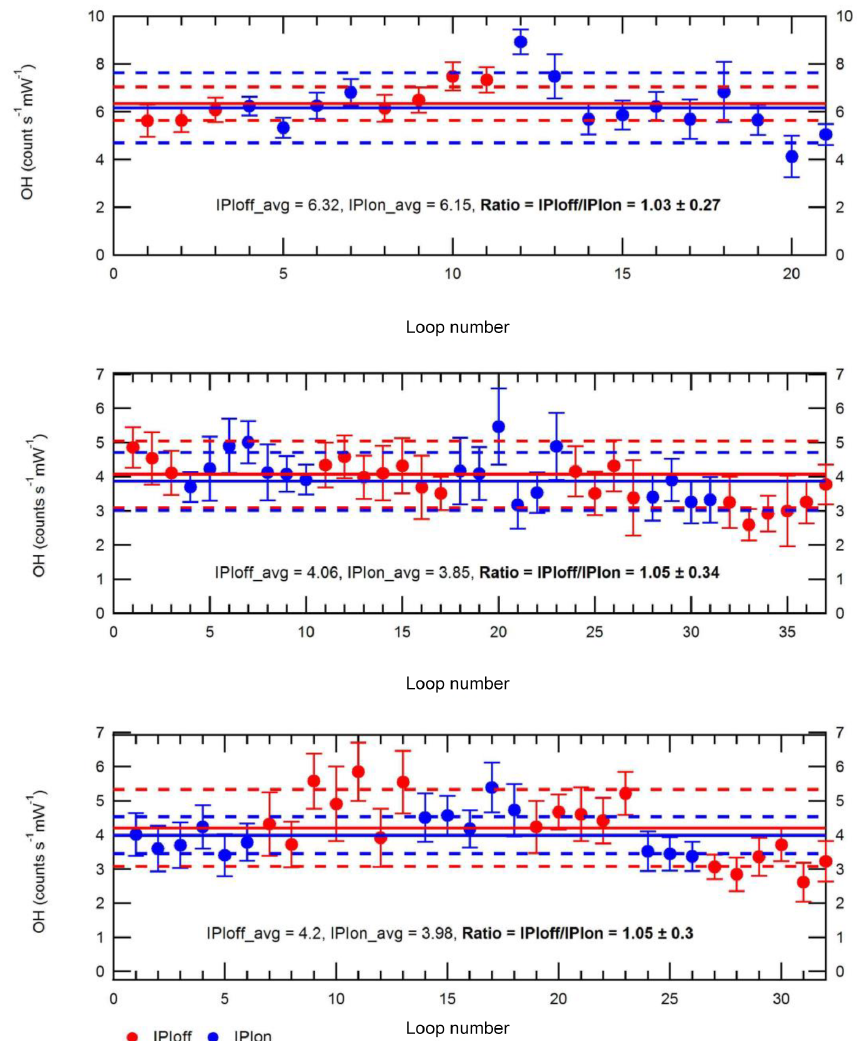
Figure 3. Testing of OH losses in the IPI system. Each panel shows repeat measurements of OH signals ( ± 2 σ ) over the course of 1d, where high OH concentrations were generated using a 184.9nm Hg lamp placed near the instrument inlet. Blue and red markers denote individual measurements (one measurement “loop”, i.e. one wavelength online–offline cycle) performed with (“IPIon”) and without (“IPIoff”) the IPI system, respectively. Solid lines correspond to the average signals for each day, with 2 σ standard deviations (SD) shown by the dashed